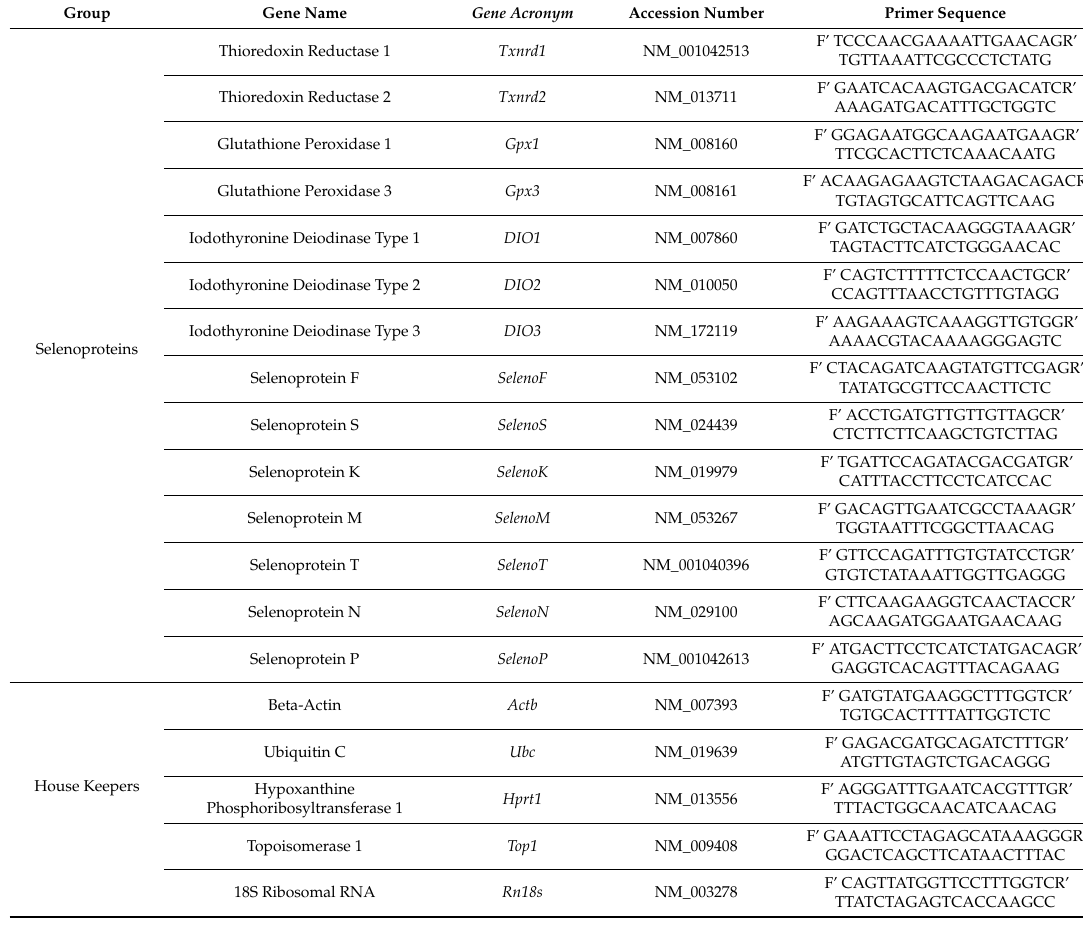
Table 5. qPCR primer list for 14 selenoproteins and 5 housekeeping